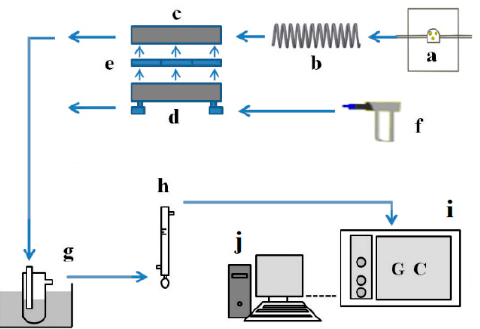
Figure 2. System of methanol steam reforming coupled with the thermoelectric module: (a) peristaltic pump, (b) vapourization and superheating heater, (c) reforming channel, (d) heating channel, (e) thermoelectric module, (f) hot air gun, (g) ice trap and gas liquid separator, (h) soap foam flow meter, (i) chromatography, and (j) workstation and computer.